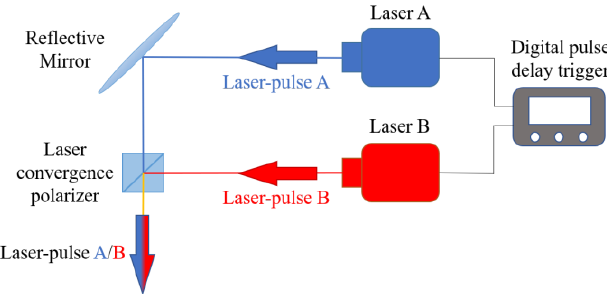
Figure 3. Standard double-pulse laser excitation signal generation